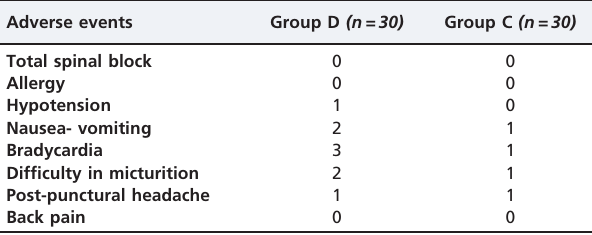
Table 3 - Patients’ perioperative adverse